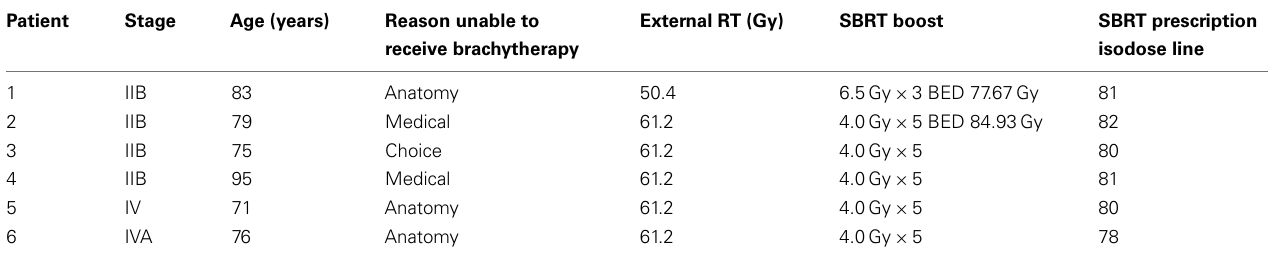
Table 1 | Patient characteristics and treatment summary.